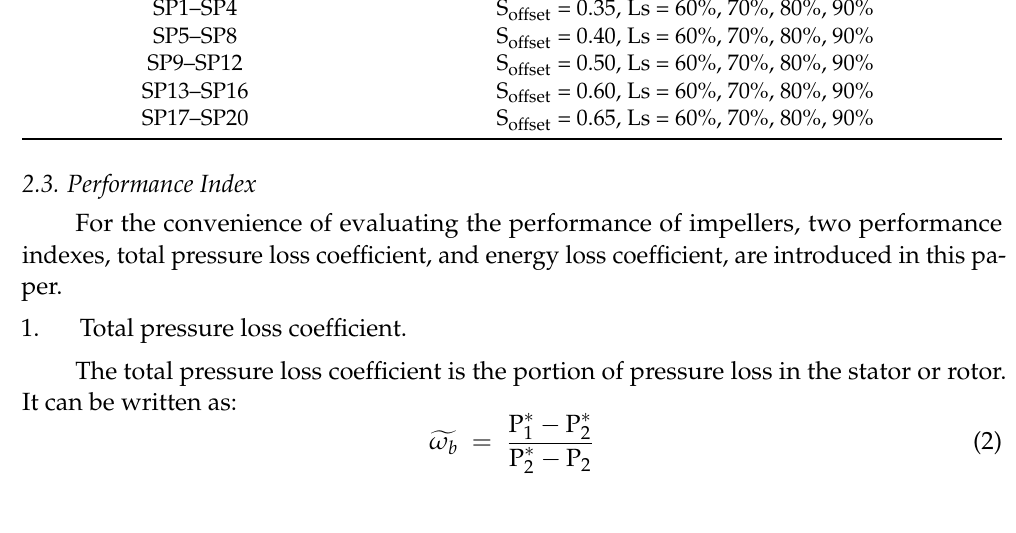
Table 4. Impeller design schemes.